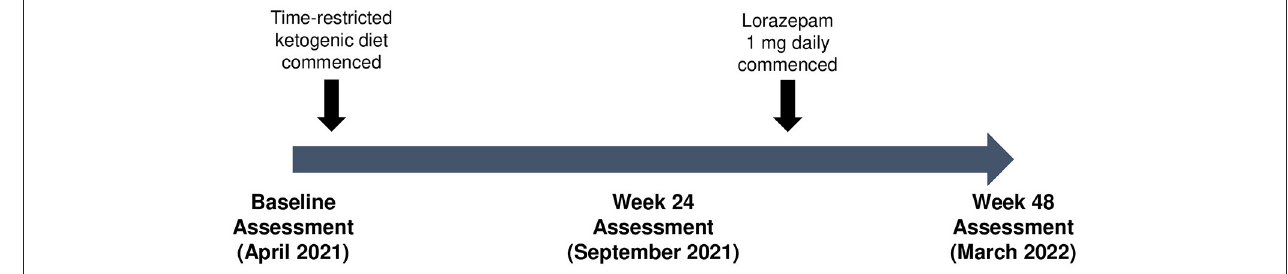
FIGURE 1 | Patient